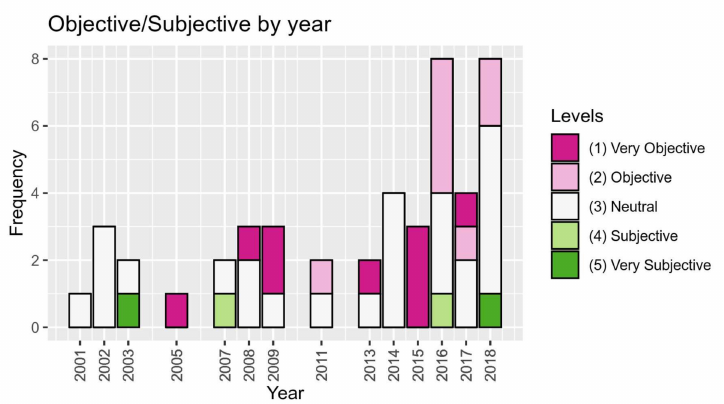
Figure 5. Frequency of sources based on levels of objective/subjective dimension over the past 20 years.